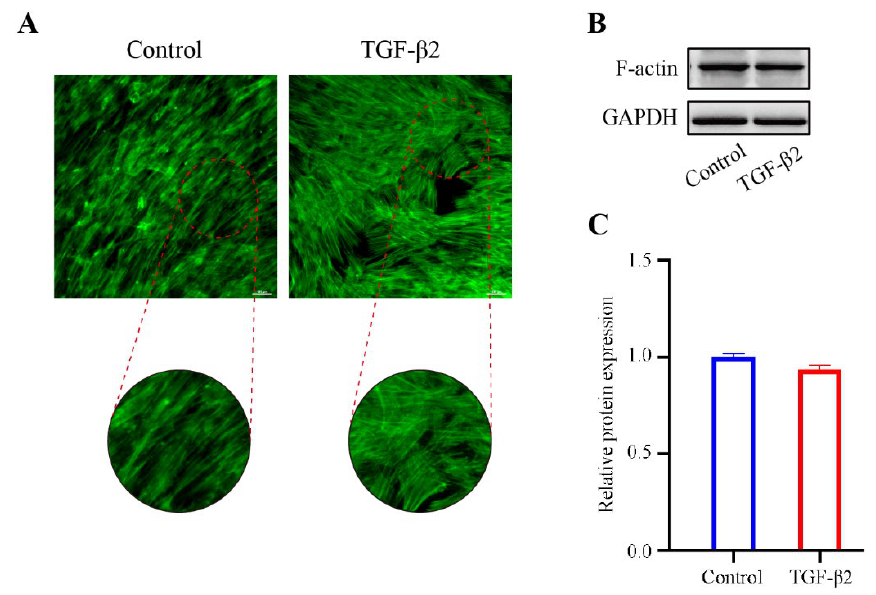
Figure 2. The effect of TGF- β 2 treatment on the cytoskeleton actin stress fibers in HTM cells. ( A ) The TGF β 2-induced changes in the cytoskeletal structure were evaluated by phalloidin fluorescence stating. ( B ) The bands of F-actin and ( C ) quantification analysis of F-actin expression levels in HTM cells treated with or without TGF- β 2 (5 ng/mL for 48 h). Scale bar: 100 µ m.